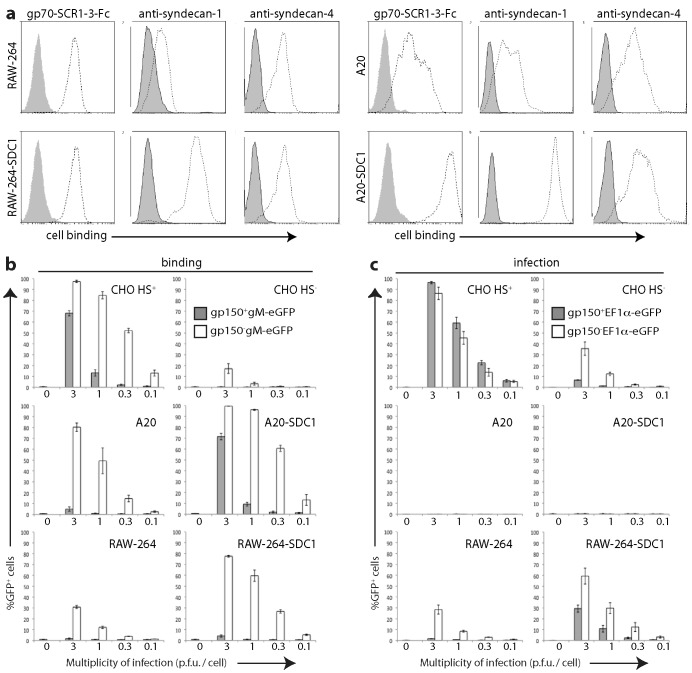
Effect of syndecan-1 up-regulation on cell binding and infection.
a. RAW-264 monocytes and A20 B cells were transduced or not with an uncleavable form of the HS carrier syndecan-1 (SDC-1). Flow cytometry confirmed syndecan-1 up-regulation; syndecan-4 staining is shown for comparison. HS expression was assayed by staining with the gp70 HS binding domains linked to IgG-Fc (gp70-SCR1-3-Fc). Open histograms show specific staining; closed histograms show staining by secondary antibody alone. Equivalent data were obtained in a repeat experiment. b. Cells were exposed to gp150+ and gp150− versions of MuHV-4 with eGFP linked to the cytoplasmic tail of gM (gM-eGFP) (4 h, 37°C). After washing ×3 in PBS, 20,000 cells were assayed for viral eGFP uptake by flow cytometry. Bars show mean ± SEM of 3 replicate experiments. 0 = no virus. SDC-1 expression significantly increased gp150+ virion binding to A20 cells and gp150− virion binding to both A20 and RAW-264 cells (p<0.01 by Student's t test for at least 2 virus dilutions). c. Cells were exposed to wild-type (gp150+) or gp150− versions of EF1α-eGFP MuHV-4 (18 h, 37°C). 20,000 cells were then assayed for viral eGFP expression by flow cytometry. Bars show mean ± SEM of 2 replicate experiments. 0 = no virus. SDC-1 expression significantly increased RAW-264 cell infection by gp150+ and gp150− viruses (p<0.01 by Student's t test for at least 2 virus dilutions) but not A20 cell infection.